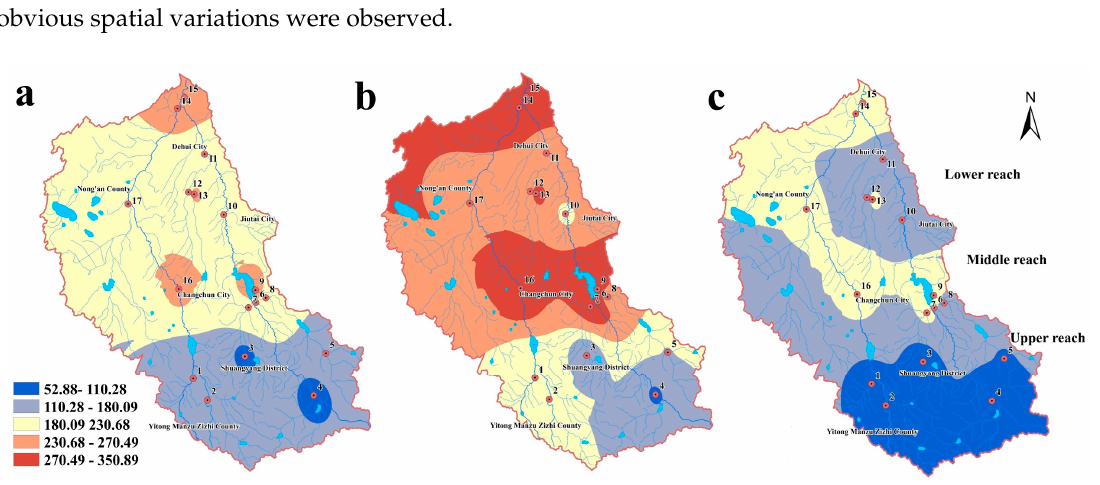
Figure 3. Spatial distribution of the total concentrations of the five phenolic compounds in water from the Yinma River Basin in three water seasons: ( a ) normal season, ( b ) wet season, ( c ) dry season.